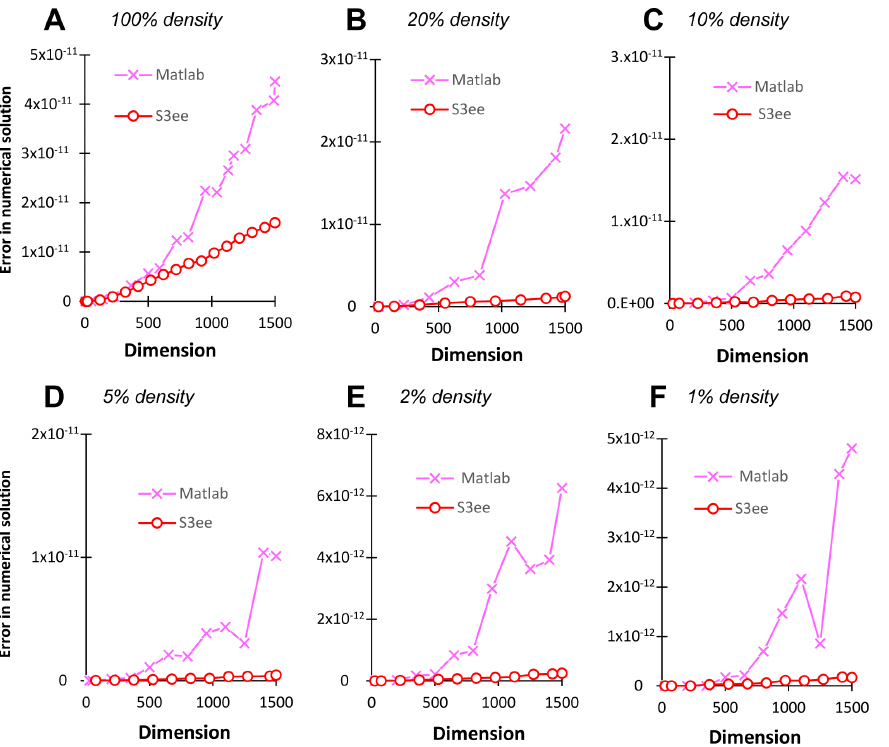
Figure 4. Comparative analysis of the computational accuracy of the ABS-based S3ee algorithm and the Matlab mldivide ( \ ) algorithm on randomly generated different-density problems.